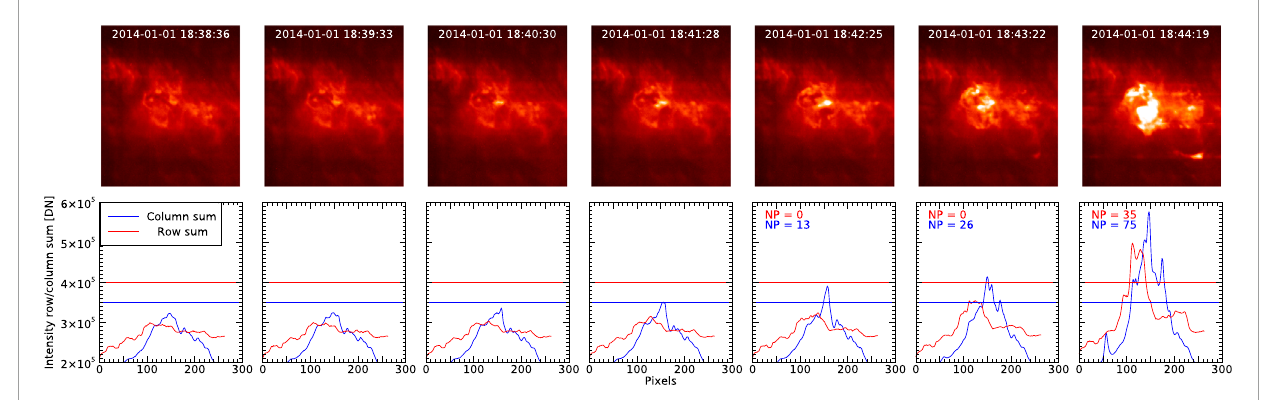
FIGURE 2 Illustration of the functionality of the EFT detection algorithm for the flare shown in Figure 1 . The top row shows EIS He II 256.32 Å wide-slit hunter images in the 6 min leading up to the flare detection. The bottom row shows how the algorithm is evaluating the intensity distributions in the images. The solid red/blue lines show the intensities summed along the rows/columns. The horizontal blue/red lines show the detection thresholds. The number of points above the detection threshold are given in the legend. The X-axis labels show spatial pixels in the solar-X direction.